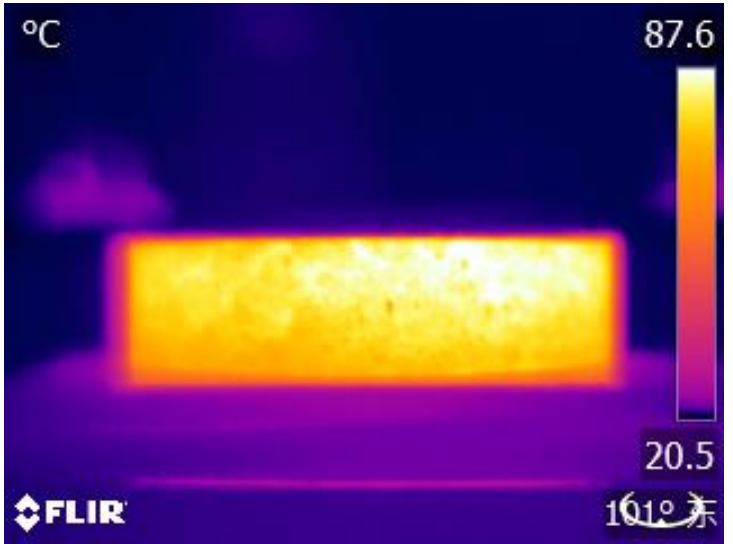
Figure 3 Induction heating test system. Figure 3. Induction heating test system.